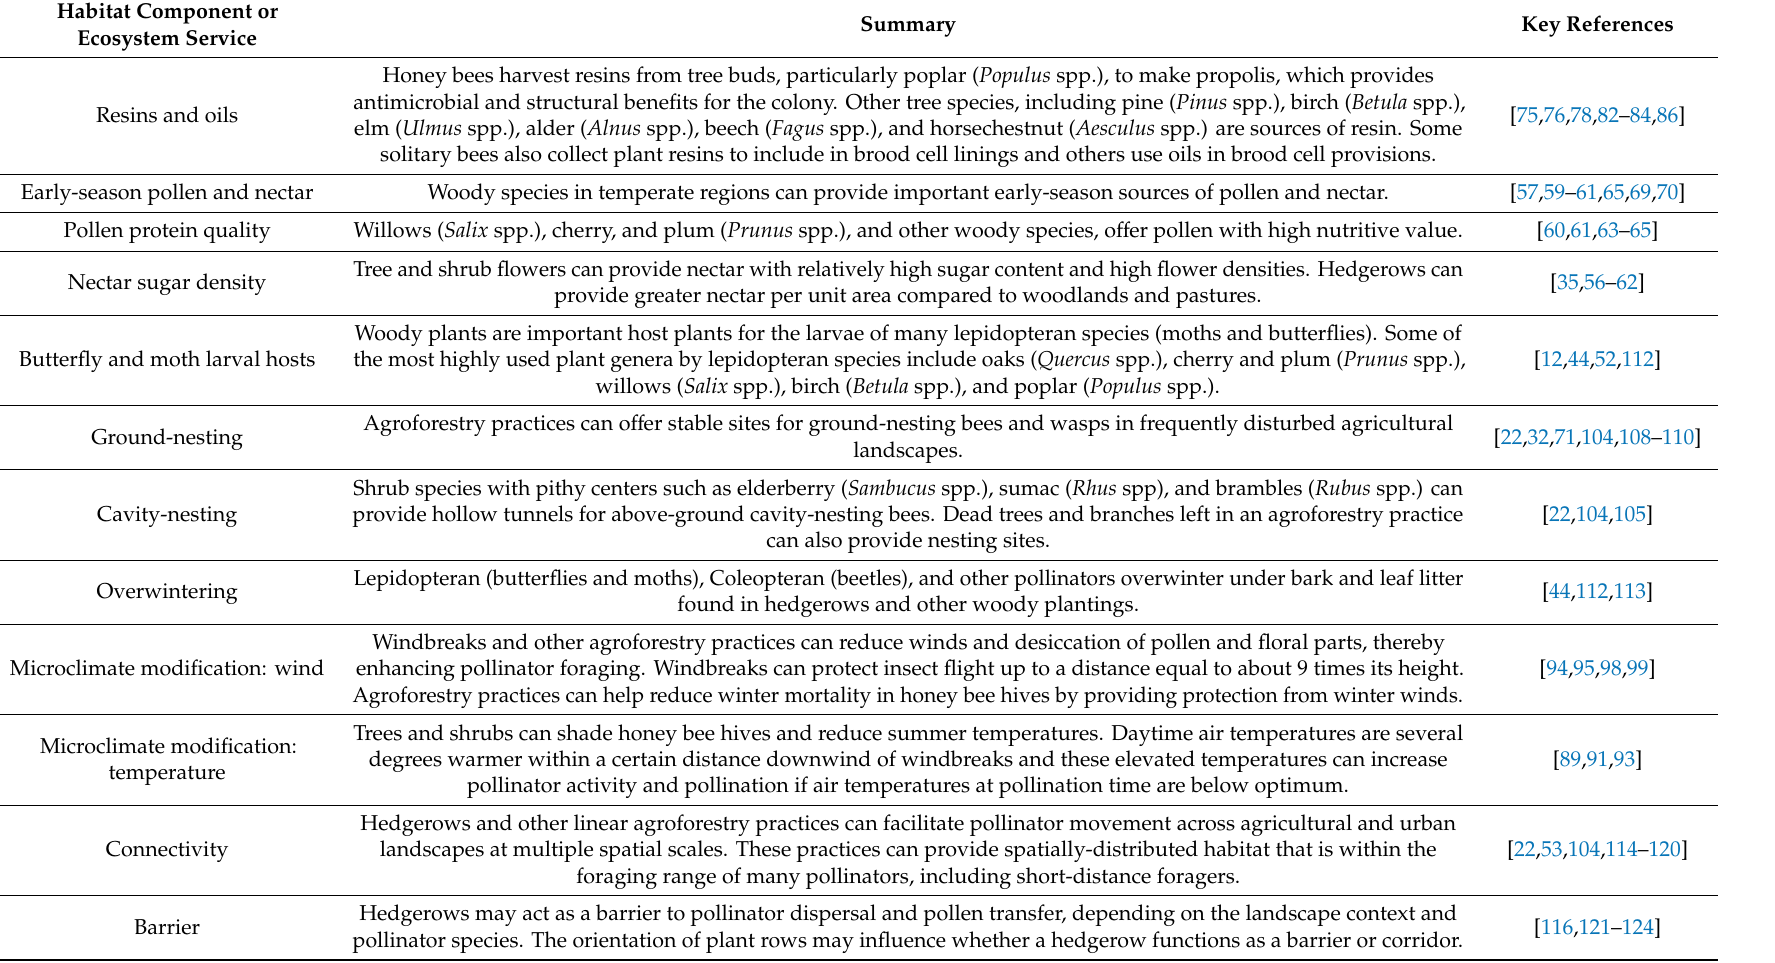
Table 1. The role of temperate agroforestry practices and woody plants on insect pollinators and pollination. Habitat Component